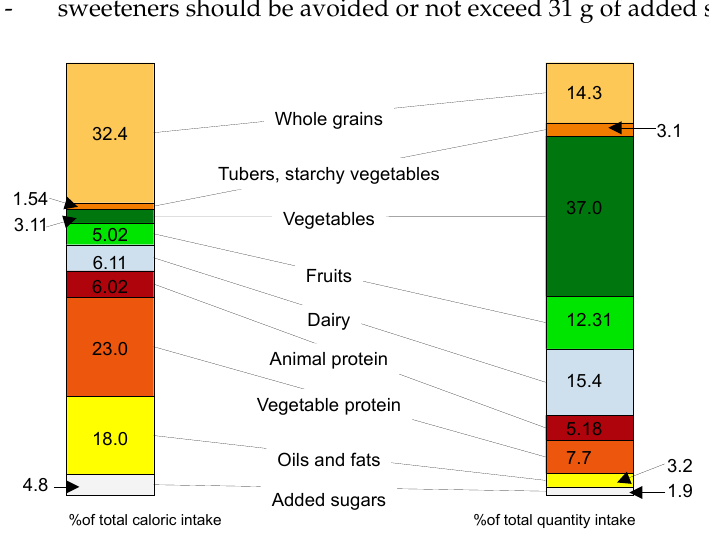
Figure 7. Caloric intake in relation to the amount of different food groups—authors own interpretation of data from [17].